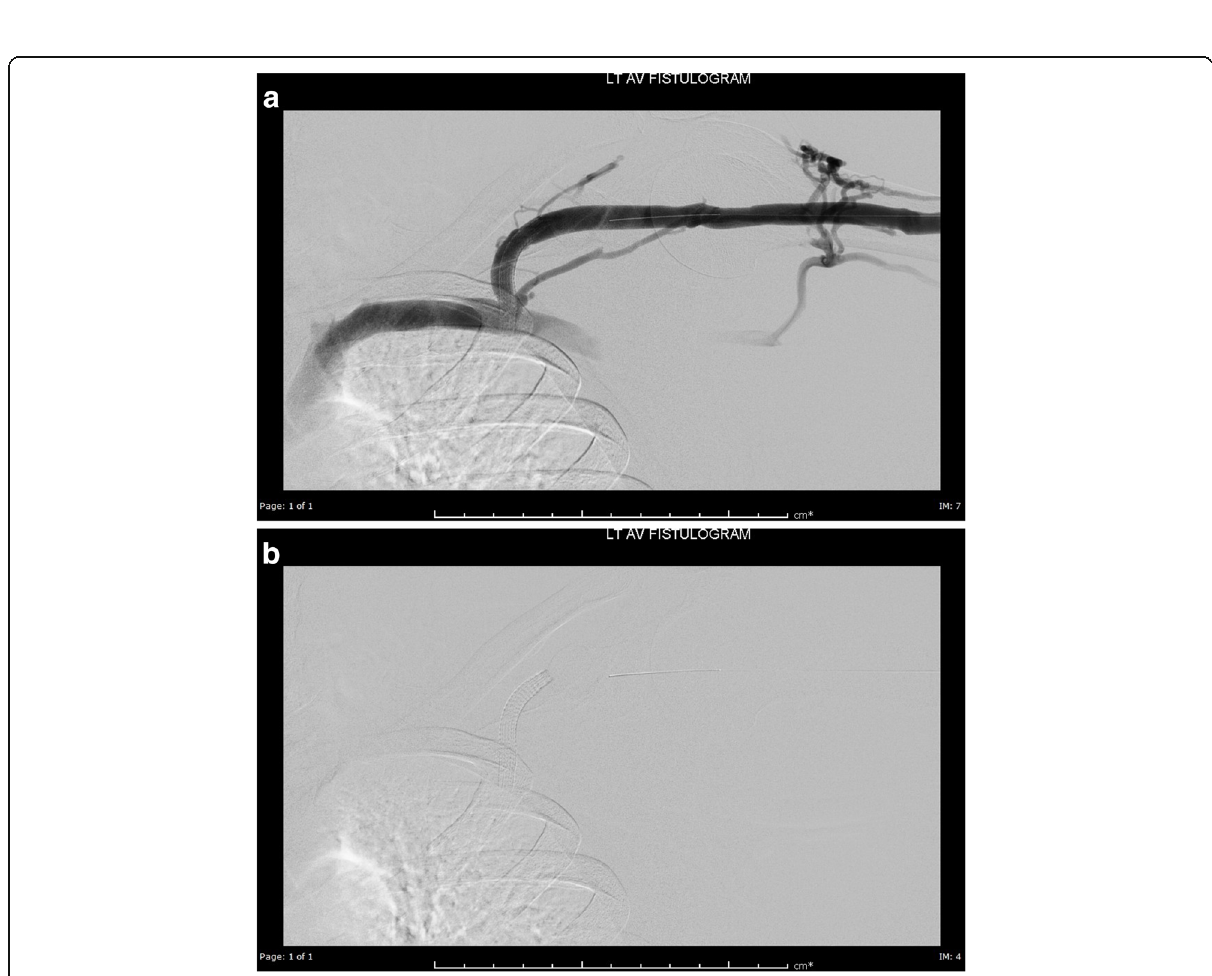
Fig. 3 a and b Immediate post stent deployment fistulogram demonstrating stent migration to cephalic arch